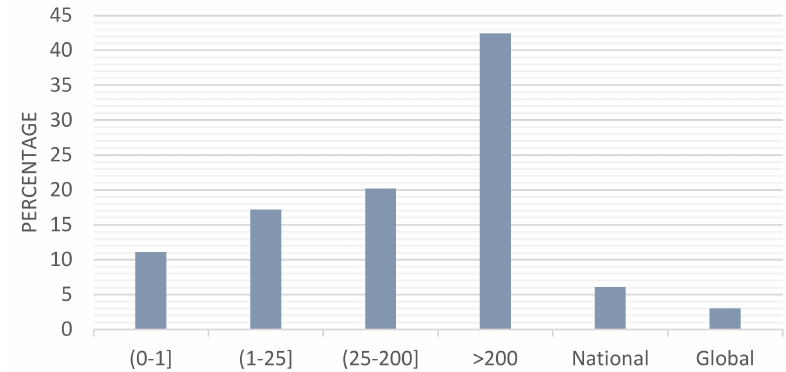
Figure 9. Distribution of the percentages of studies according to their extension (km 2